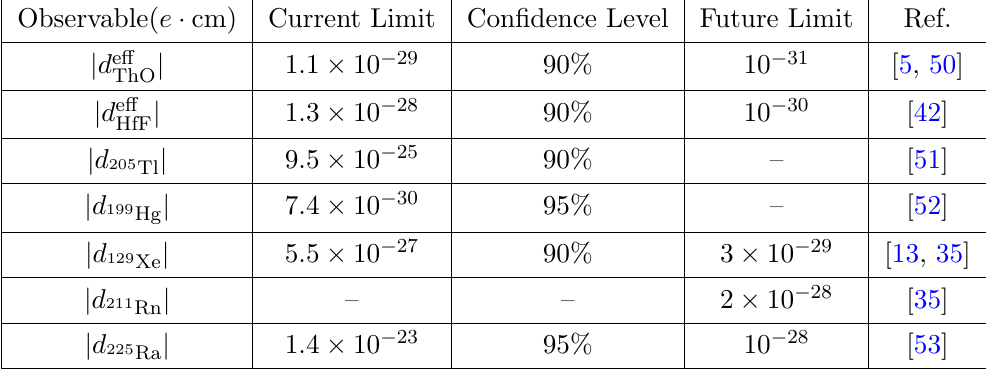
Table 4 . Current and future experimental upper limits on various observable EDMs. The con(cid:12)- dence level refers to current